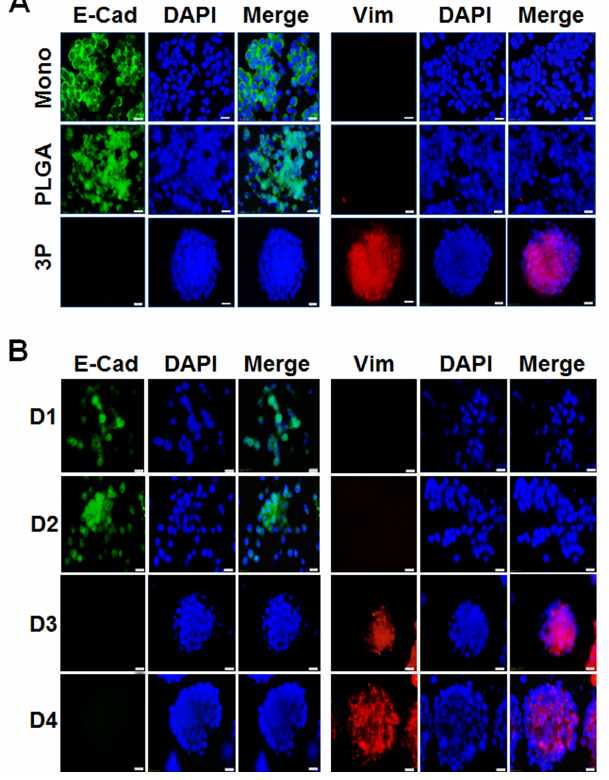
Figure 4. 3P scaffold tumoroids showed EMT. LLC1 cells cultured on monolayer, PLGA or 3P scaffolds, fixed and immunostained with anti-E-cadherin (green), anti-vimentin (red) and DAPI (blue) for staining nuclei. (A) Tumoroids fixed at day 3; (B) Timeline of EMT induction. Scale bar=20 m m.